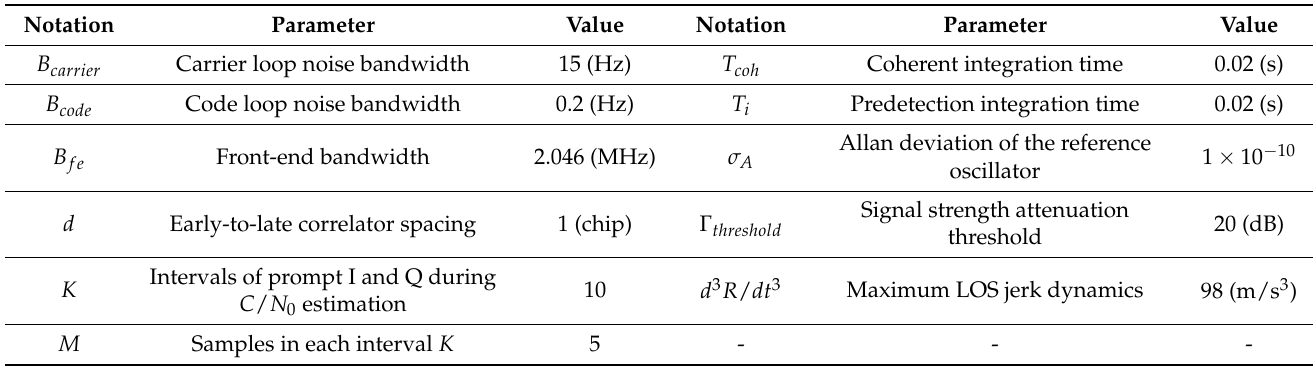
Table 3. The value of receiver-related parameters during simulation.